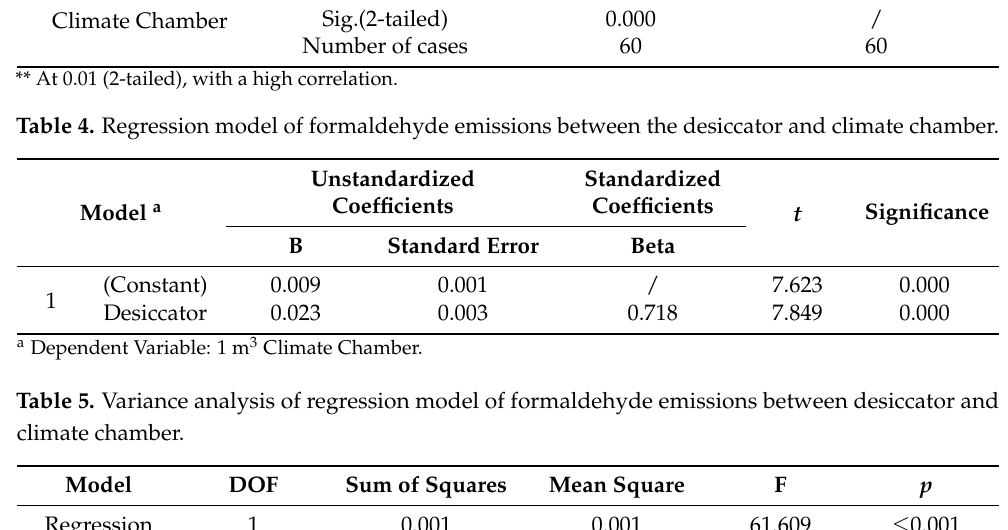
Table 3. Correlation analysis of formaldehyde emissions between the desiccator and climate chamber. Desiccator Climate Chamber Pearson correlation 1 0.718 ** Sig.(2-tailed) / 0.000 Desiccator Number of cases 60 60 Pearson correlation 0.718 ** 1 Sig.(2-tailed) 0.000 / Climate Chamber Number of cases 60 60